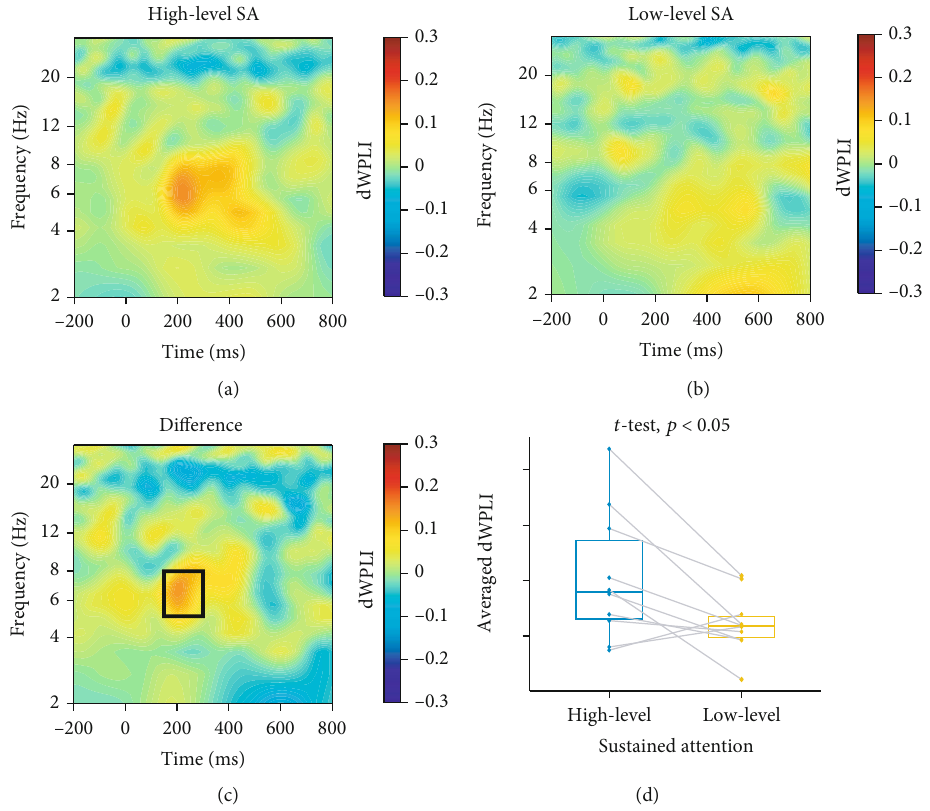
Figure 5: Phase-based connectivity between pMFC (Fz) and LPFC (F3). DWPLI of (a) high-level and (b) low-level sustained attention (here abbreviated as SA) was computed by averaging across all subjects. (c) The di ff erence between high-level and low-level sustained attention (high-level minus low-level) was demonstrated. The bold black rectangle shows the interested time-frequency window (150- 300ms and 5-8Hz). (d) The averaged dWPLI of high-level sustained attention was signi fi cantly larger than that of low-level sustained attention, t ð 9 Þ = 2 : 68 , p < 0 : 05